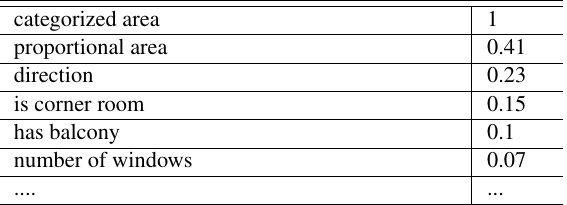
Table 1. Excerpt of the most important features and their weights for the classification of the functional use kitchen-living . The weights are derived using the reliefF algorithm.